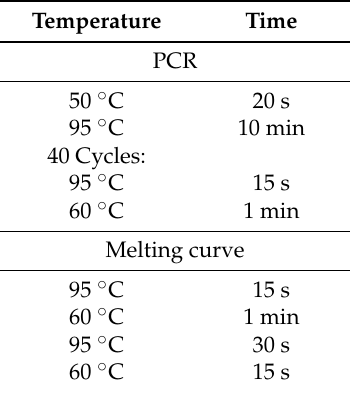
Table 3. Real-time qPCR